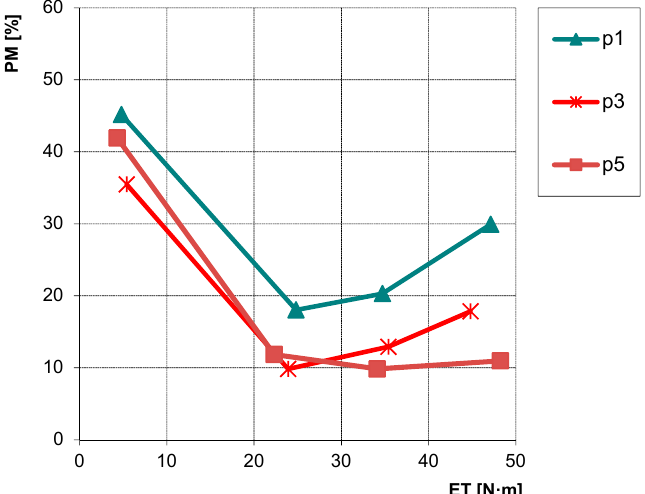
Figure 11. Changes in PM emissions under load characteristics.